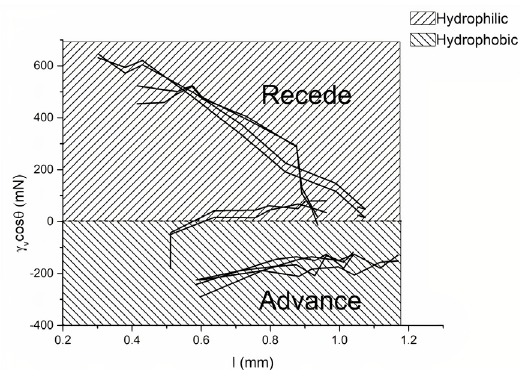
Figure 5. Graph following Wilhelmy equation that describes the loop movement of advancing and receding dynamic contact angle in hydrophilic and hydrophobic